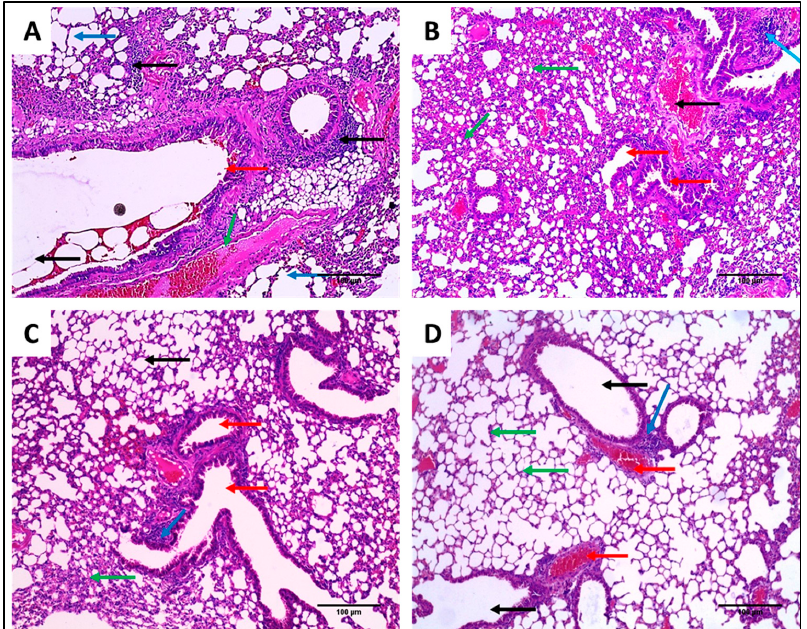
Figure 13. H&E staining of lung sections of ( A ) Group I showing dilated destructed alveoli (emphysema) (blue arrows) surrounded by fibrosis and dilated bronchioles (red arrow) surrounded by chronic inflammation (black arrow) and congested vessel (green arrow) ( × 200). ( B ) Group II showed dilated destructed bronchioles (red arrows) surrounded by marked alveolar fibrosis (green arrows), chronic inflammation (blue arrow), and congested vessels (black arrow) ( × 200). ( C ) Group III showed focal inflammation (blue arrow) with average-sized bronchioles (red arrows) surrounded by normal-sized alveoli (black arrow) with residual areas of alveolar fibrosis (green arrow) ( × 200). ( D ) Group IV showed minimal inflammation (blue arrow) surrounded by normal-sized bronchioles (black arrow) and normal-sized alveoli (green arrows) with very few congested vessels (red arrows) ( × 200).